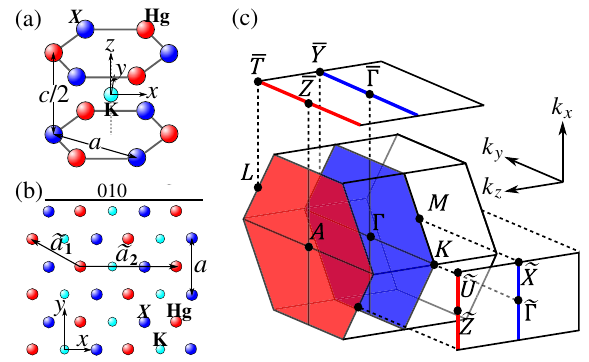
FIG. 2. (a) 3D view of atomic structure. The Hg (red) and X (blue) ions form a honeycomb layers with AB stacking. The K ion (cyan) is located at an inversion center, which we also choose to be our spatial origin. (b) Top-down view of atomic structure that is truncated in the 010 direction; two of three Bravais-lattice vectors are indicated by ~ a 1 and ~ a 2 . (c) Center: bulk Brillouin zone ¯ M (BZ) of KHg X , with two mirror planes of colored red and z blue. Top: 100-surface BZ. Right: 010-surface